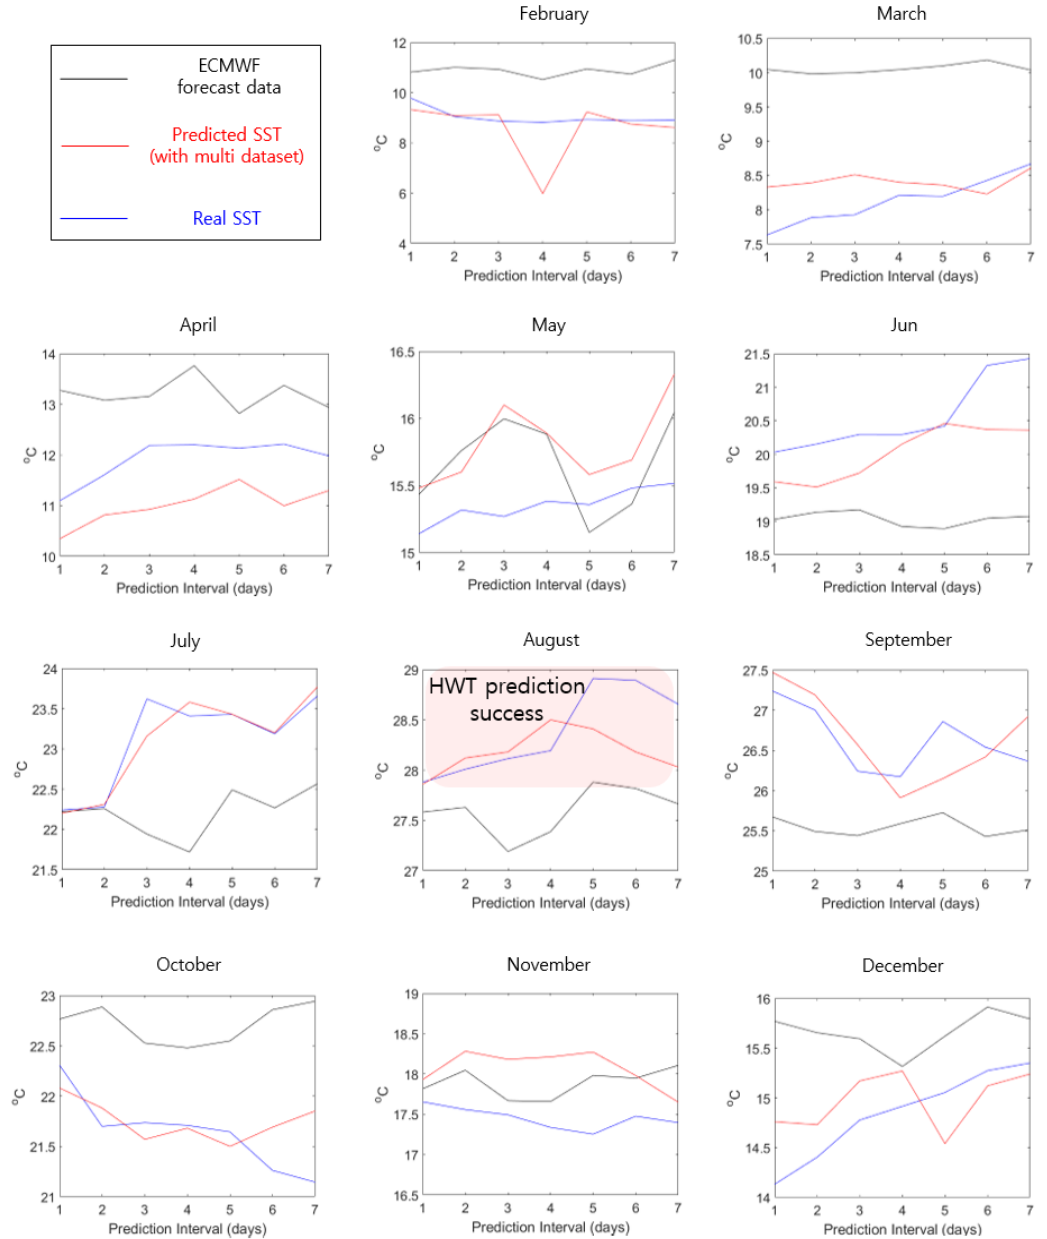
Figure A3. Comparison of SST prediction performance for August between the proposed model (with multi-dataset input) and European Center for Medium-Range Weather Forecast (ECMWF) forecast data.